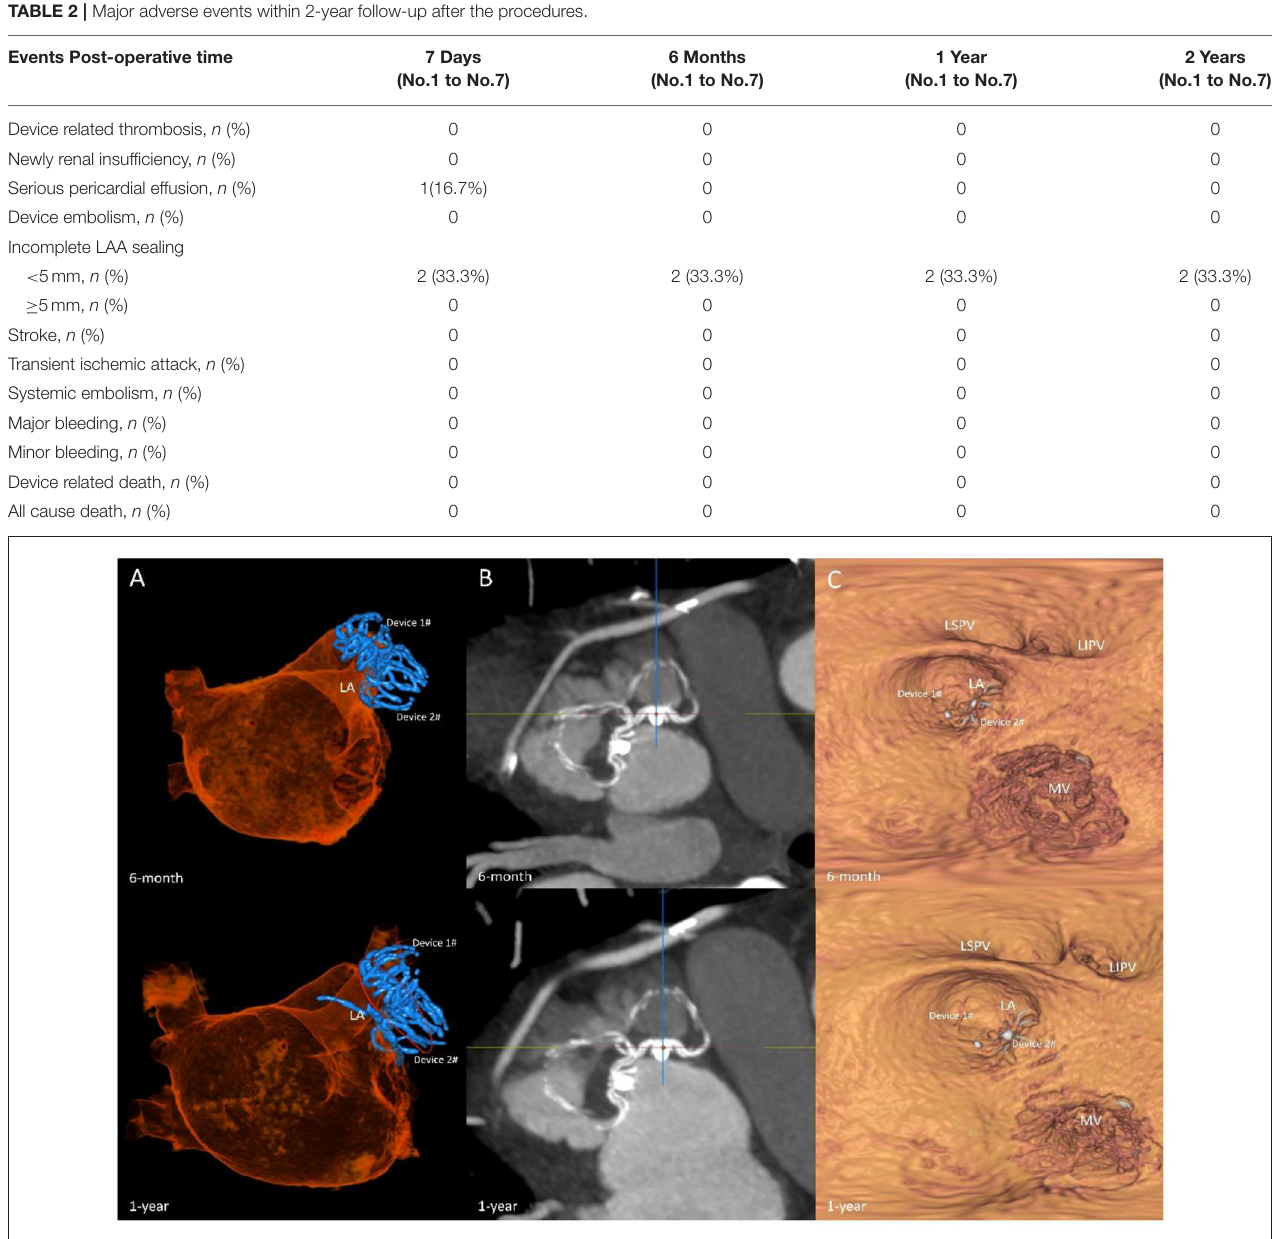
FIGURE 5 | Follow-up imaging. Multiplanar reconstruction evaluating the anatomic position (A) ; volume-rendering CT image evaluating the residual shunt after surgery (B) ; multiplanar reconstruction evaluating the endothelialization of the occlusions (C)